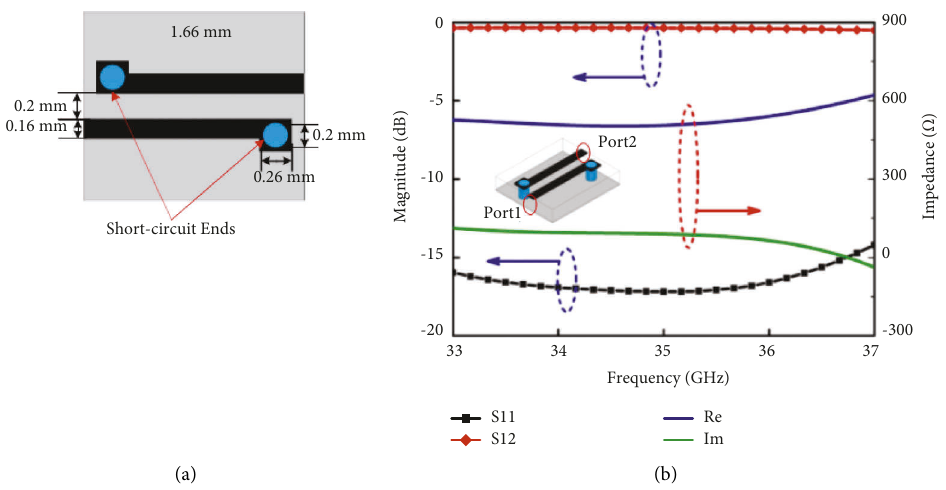
Figure 3: (a) Configuration of coupled microstrip line with two shorts. (b) Simulation results.